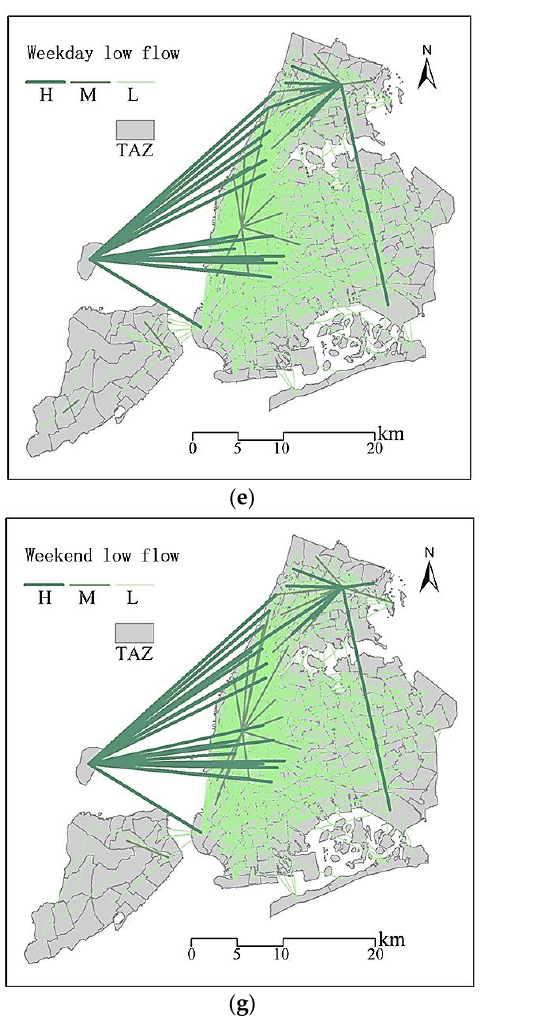
Figure 13. Changes in the stability of taxi travel flow for geographic units. ( a ) Low travel flow on weekdays in Shenzhen. ( b ) High travel flow on weekdays in Shenzhen. ( c ) Low travel flow on weekends in Shenzhen. ( d ) High travel flow on weekends in Shenzhen. ( e ) Low travel flow on weekdays in New York. ( f ) High travel flow on weekdays in New York. ( g ) Low travel flow on weekends in New York. ( h ) High travel flow on weekends in New York.